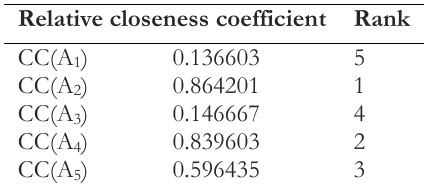
Table 7. Relative closeness coefficient and ranking of different alternatives.